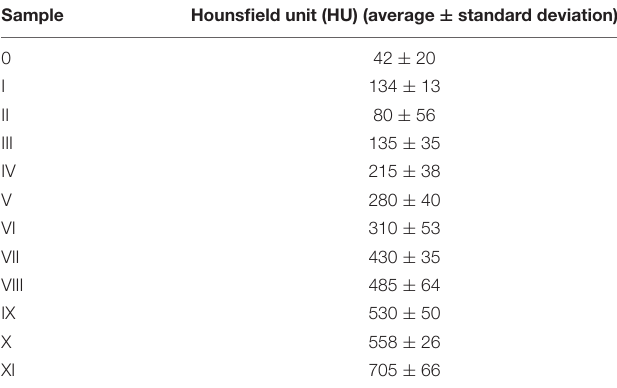
TABLE 2 | Resulting HUs related to twelve different radiopaque amalgamate samples used in this study.